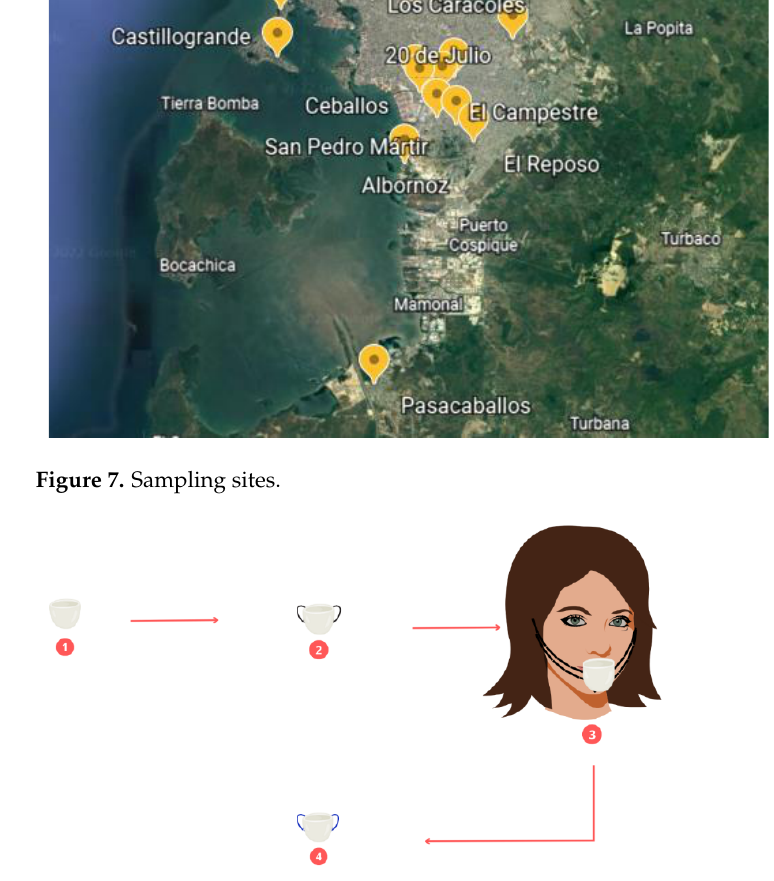
Figure 7. Sampling sites.